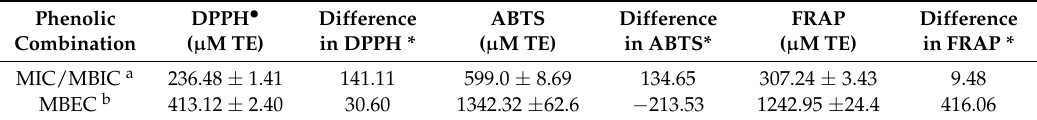
* Difference represents the subtraction of the experimental antioxidant capacity value for the combination minus the expected theoretical value (considered as the addition of the experimental values of the individual compounds). a MIC/MBIC = 1.62 mM protocatechuic acid + 0.74 mM vanillic acid + 0.05 mM catechin (this combination was diluted 25 times to fit the Trolox standard curves). b MBEC = 3.20 mM protocatechuic acid + 2.97 mM vanillic acid + 1.72 mM catechin (this combination was diluted 25 times to fit the Trolox standard curves). Theoretical